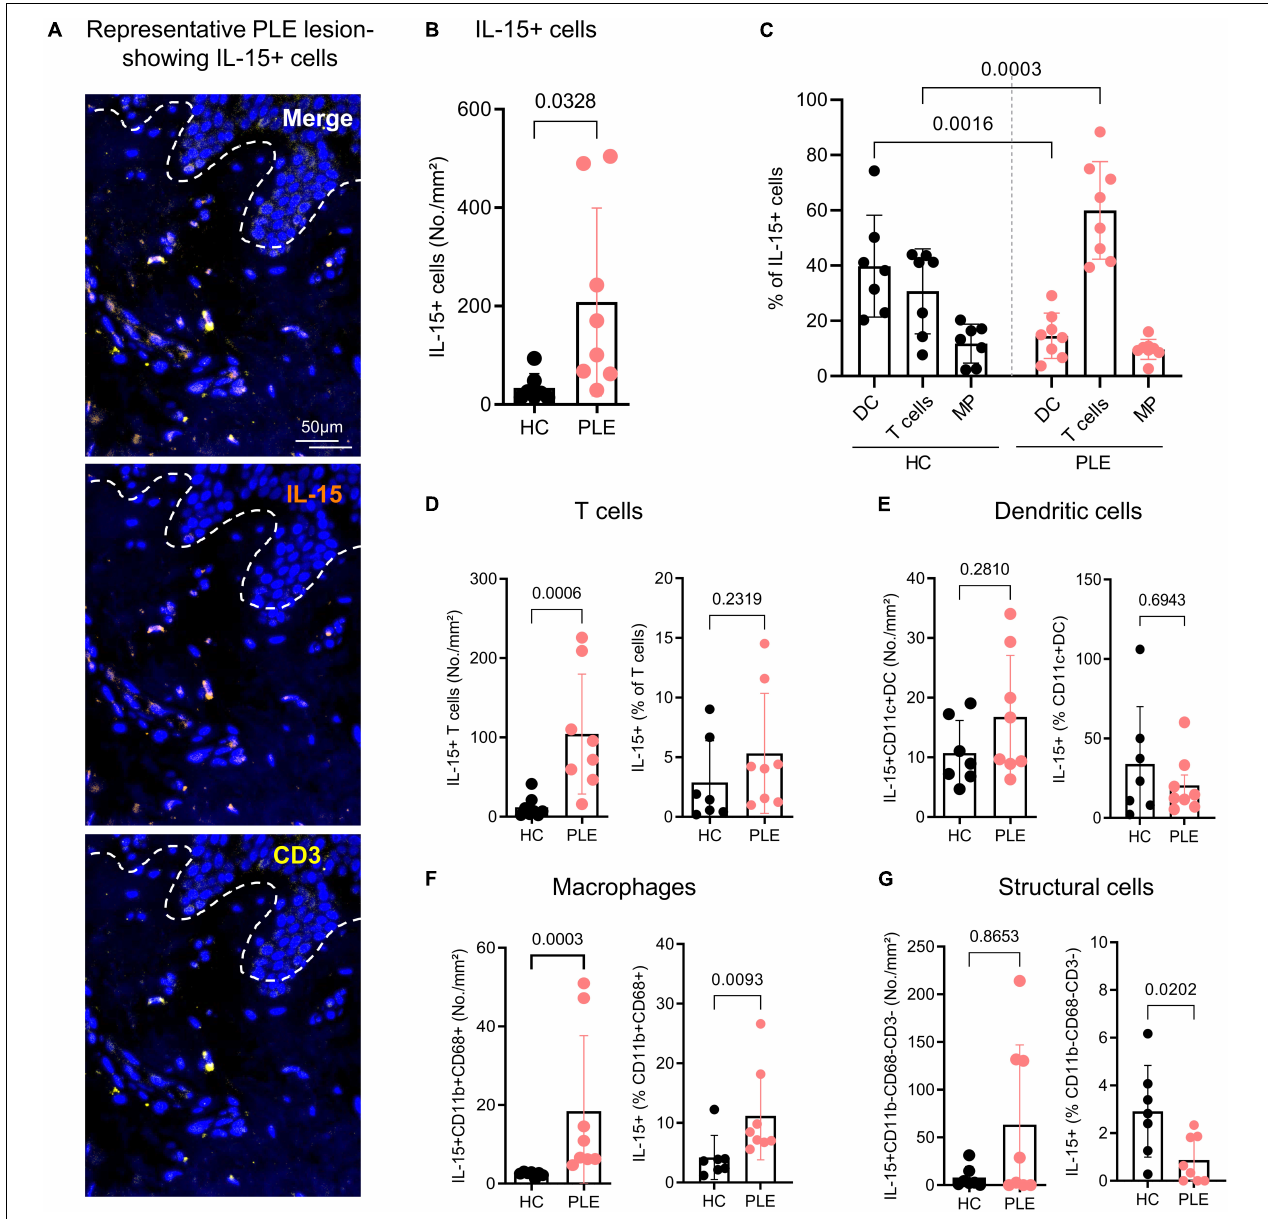
FIGURE 4 | CD3 + T cells and CD68 + macrophages are the major cellular source of IL-15 in PLE. (A) Representative immunofluorescent image of IL-15 + CD3 + T cells in PLE; dotted line indicates the dermo-epidermal border. (B) Number of IL-15-producing DAPI + cells in healthy control (HC) skin and polymorphic light eruption (PLE) lesions. Data shown as a mean cell number/mm 2 ± SD. (C) Cellular source of IL-15 in PLE; data shown as a percentage of dendritic cell (DC), T cells, and macrophages (MP) of total IL-15 + cells ± SD. (D–G) Mean number and percentage of IL-15-producing CD3 + T cells (D) , CD11c + dendritic cells (E) , CD11b + CD68 + macrophages (F) and CD11b − CD68 − CD3 − structural cells (G) per mm 2 ± SD in HC skin and PLE. Statistical analysis with Mann–Whitney test, (HC: n = 7, PLE: n =